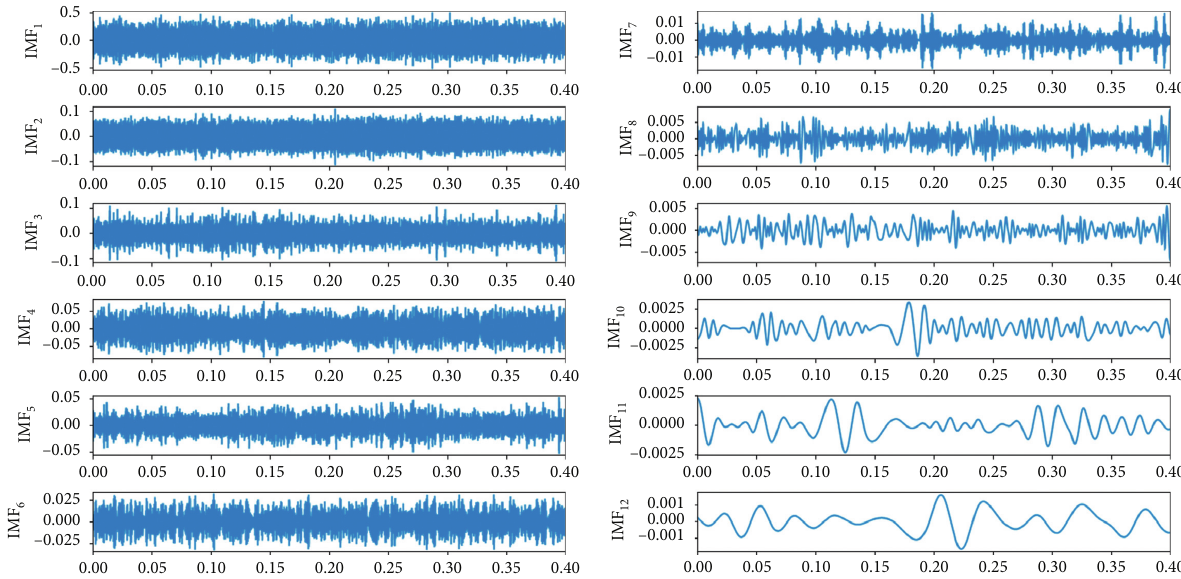
Figure 4: Time-domain diagram of the IMF components of a vibration signal based on a rolling ball fault. Table 5: Performance comparison of CEEMDAN and EEMD.